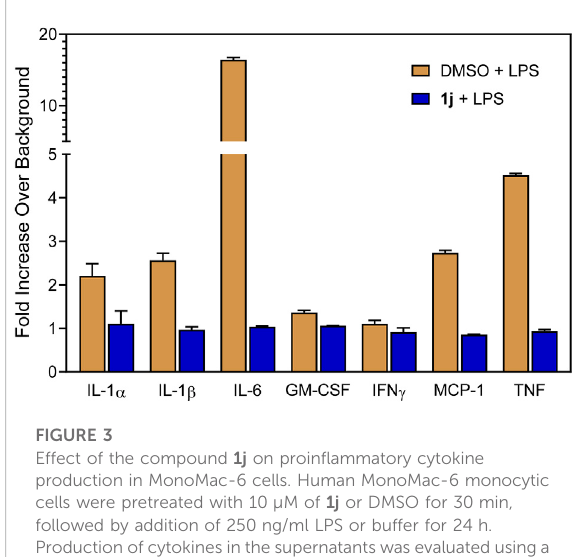
FIGURE 3 Effect of the compound 1j on proin fl ammatory cytokine production in MonoMac-6 cells. Human MonoMac-6 monocytic cells were pretreated with 10 μ M of 1j or DMSO for 30 min, followed by addition of 250 ng/ml LPS or buffer for 24 h. Production of cytokines in the supernatants was evaluated using a Multiplex human cytokine ELISA kit. The relative level of cytokine production is shown as fold increase over background (i.e., 1% DMSO control). The data are presented as the mean ± S.D. of triplicate samples from one experiment that is representative of two independent